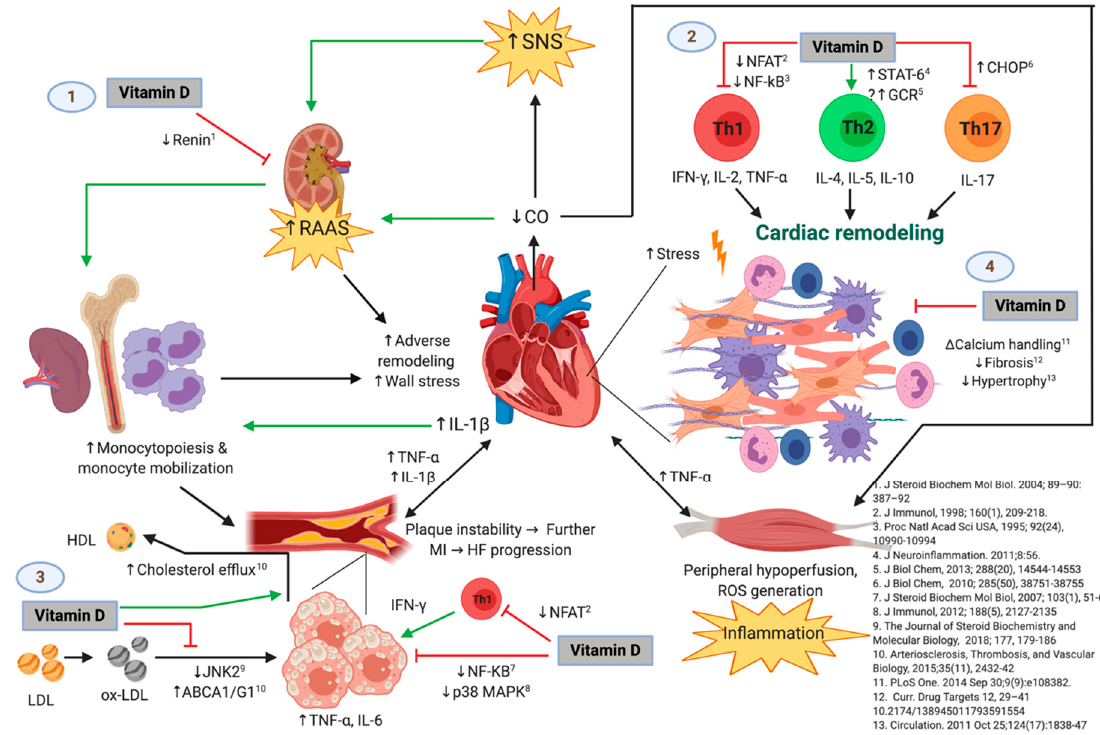
Figure 6. The Possible Immunomodulatory Role of Vitamin D in the Context of Heart Failure (HF) Progression. Green and black lines with arrowheads represent a direct stimulation and a positive correlation, respectively. Red lines ending in perpendicular bars indicate inhibition. ( ↑ ) represent an increase in expression, concentration, or activity of the parameter or mechanism. ( ↓ ) indicate a decrease in expression, concentration, or activity of the parameter of mechanism. HF is initiated and maintained by chronic maladaptive activation of neurohumoral networks that result from decreased cardiac output (e.g., the sympathetic nervous system [SNS] and the renin-angiotensin-aldosterone system [RAAS]), innate and adaptive immune mechanisms triggered by myocardial damage and stress, and systemic inflammation that results from hypoperfusion of peripheral organs [20,21]. Vitamin D may play a protective role in the progression of HF by interfering with several deleterious pathways [25], which include but are not limited to: (1) inhibiting the release of renin [44], which leads to attenuated RAAS-mediated adverse cardiac remodeling and release of monocytes from bone marrow and lymphoid tissue (an event that is also favored by IL-1 β and perhaps other inflammatory cytokines from damaged myocardium) [21]. Monocytes are known to infiltrate damaged myocardium [45] and atheromatous plaques [35], where they exacerbate the local inflammatory response and promote further adverse ventricular remodeling as well as growth and instability of atherosclerotic plaques, respectively. Hence, vitamin D may indirectly attenuate monocyte / macrophage-mediated myocardial damage. (2) Vitamin D may also favor an anti-inflammatory T-helper lymphocyte phenotype by decreasing Th1 [46–48] and Th17 [9,23] cytokine production and favoring the Th2 phenotype [49], which would theoretically promote adequate remodeling and decreased fibrosis, and reduce cardiomyocyte hypertrophy and dysfunction. (3) Vitamin D could also slow the progression of atherosclerotic plaques by inhibiting the proinflammatory activation of foam cells (macrophages that have phagocytosed ox-LDL particles) through diminished ox-LDL capture [38], increased cholesterol efflux [37], and decreased activation of transcription factors involved in the expression of proinflammatory cytokines such as TNF- α and IL-6 [22,50]. Like the mechanism described above, vitamin D may also act on T-lymphocytes present in atherosclerotic plaques, decreasing IFN- γ production and hence proinflammatory polarization of macrophages/foam cells. This is of relevance, as growth of atherosclerotic plaques results in plaque instability and further myocardial infarction, with consequent exacerbation of the pathogenic loop that characterizes HF. (4) Vitamin D has also